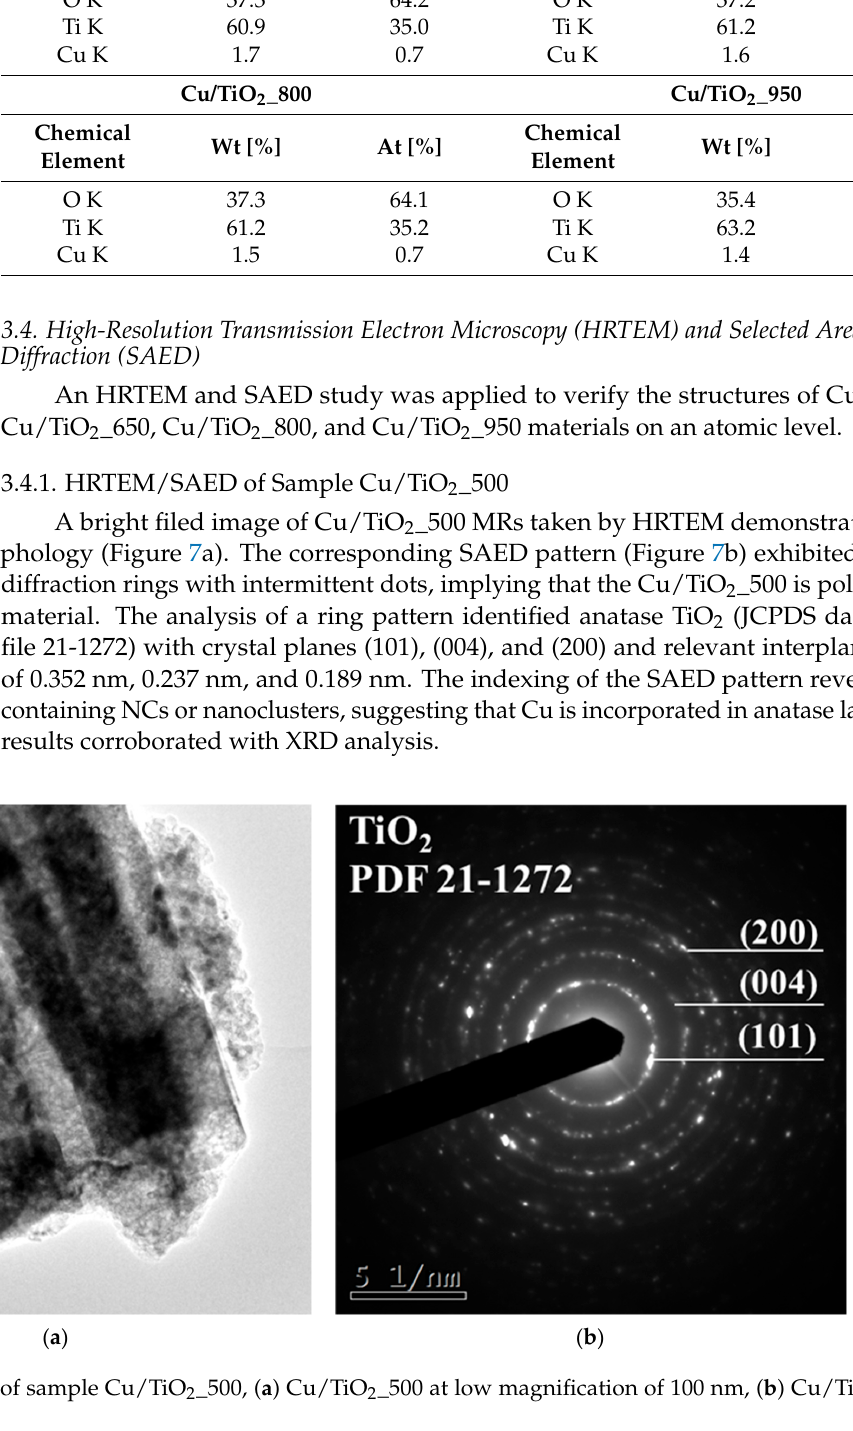
Table 2. EDS analysis of annealed Cu/TiO 2 _500, Cu/TiO 2 _650, Cu/TiO 2 _800 and Cu/TiO 2 _950.